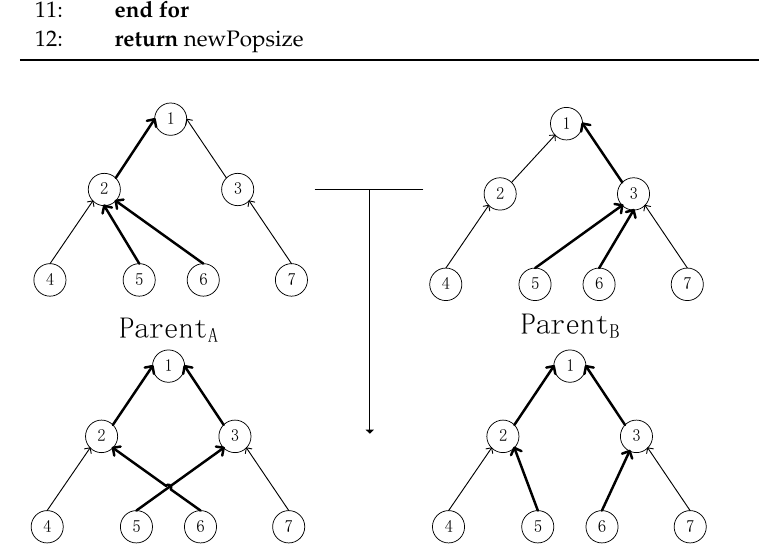
Figure 6. Crossover operator instance.